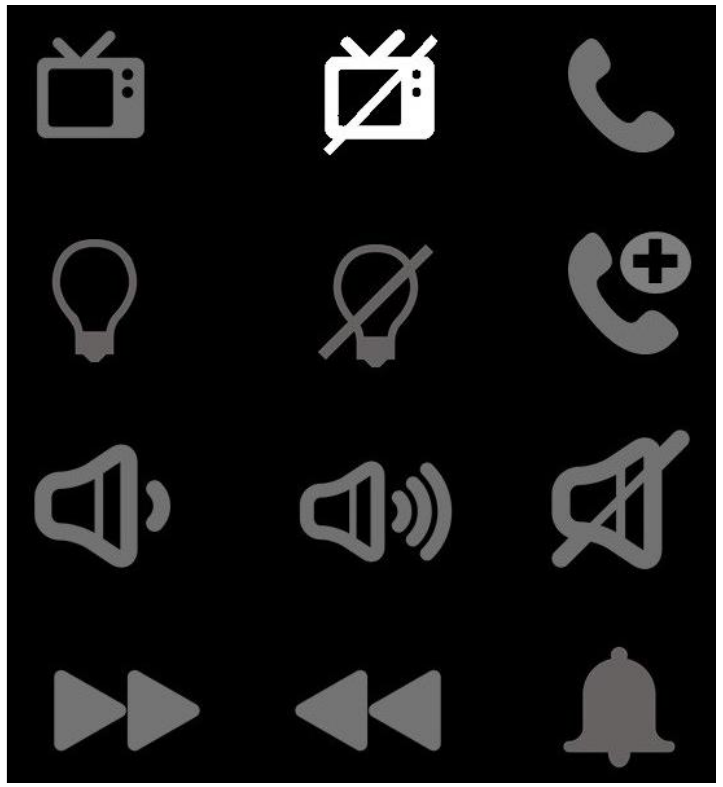
Figure 2. Primary Display to control the smart home. The subjects were told to randomly choose a symbol and focus on the chosen symbol and count how many times it flashed quietly. After 300 ms of the target symbol flashing, P300 appears. Intensifications are randomized in blocks. Each symbol is intensified exactly once in random order in each block of twelve intensifications. This intensification block is repeated fifteen times in total. We employed a 100 ms intensification time with a 75 ms blank interval in